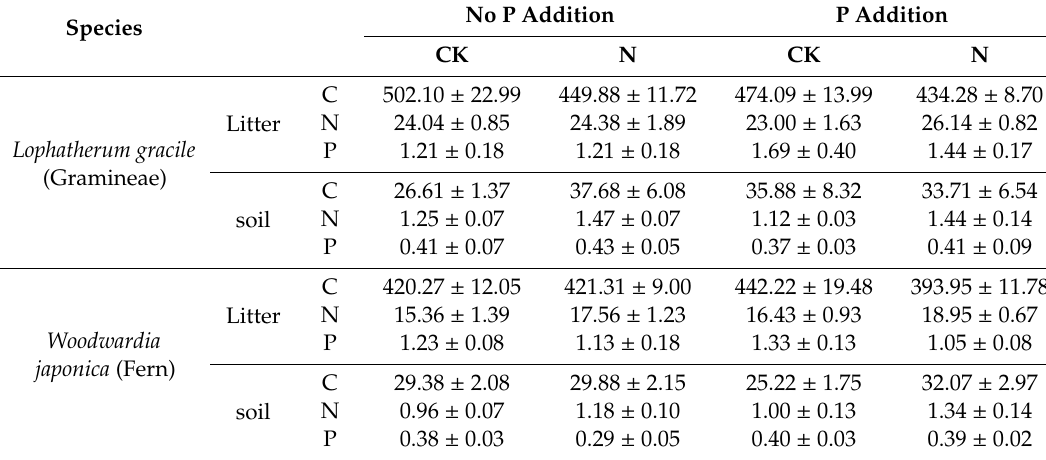
Table A1. The values of organic C (C), total N (N) and total P (P) in litter and soil of four plants under the addition of N and P (means ±